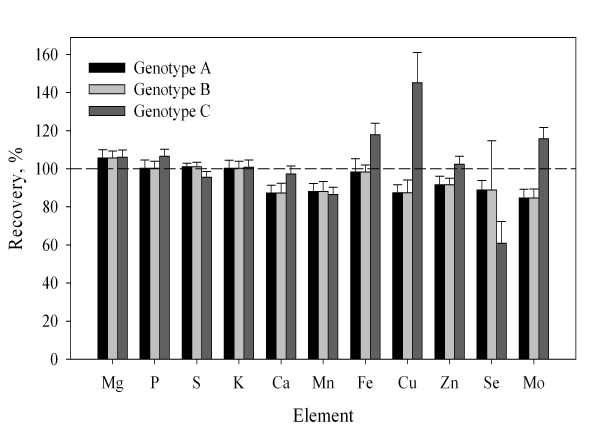
Tissue concentrations of mineral elements in single grains of Oryza sativa L. cvs TSN1 (genotype A), Hom Nang Nouan (genotype B) and Kai Noi Leuang (genotype C). Values are expressed relative to data from macro-scaled analysis (250 mg) of finely pulverized grains of the same cultivars. Values are means + SE (n = 10).